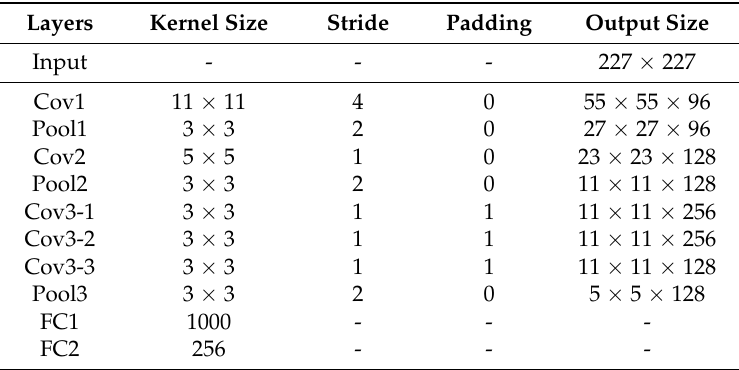
Figure 5. The architecture of a compact convolutional neural network (CNN). Table 2. Structural configuration of the compact